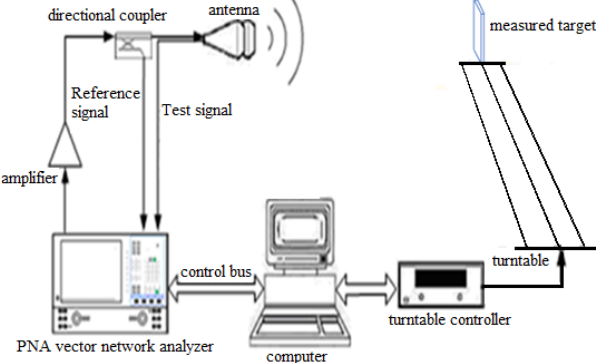
Figure 13. RCS test system in the electromagnetic darkroom.